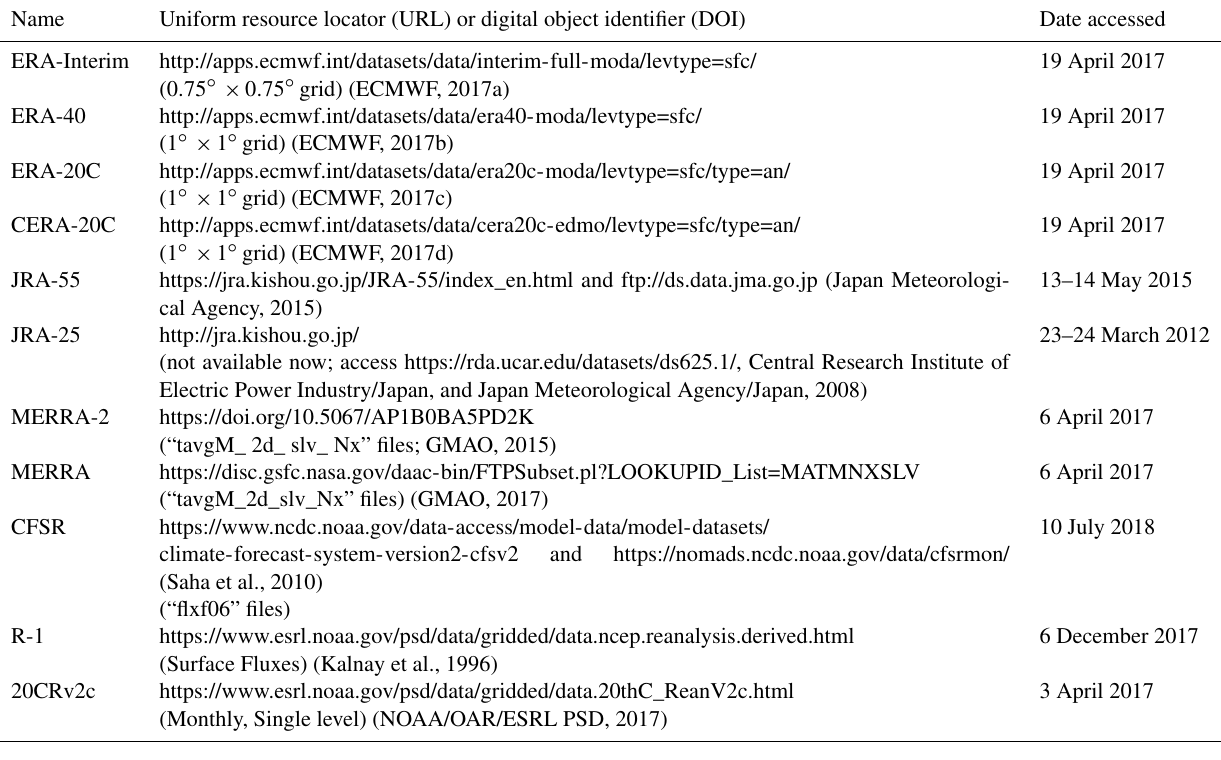
Table 3. Monthly mean 2m temperature data from global atmospheric reanalysis data sets.